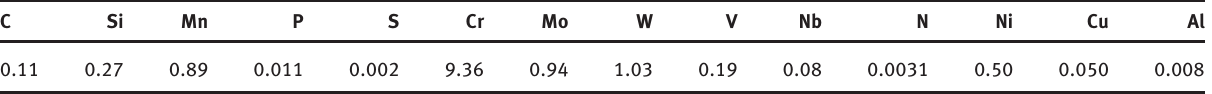
Table 1: The chemical composition of ZG1Cr10MoWVNbN steel (%).